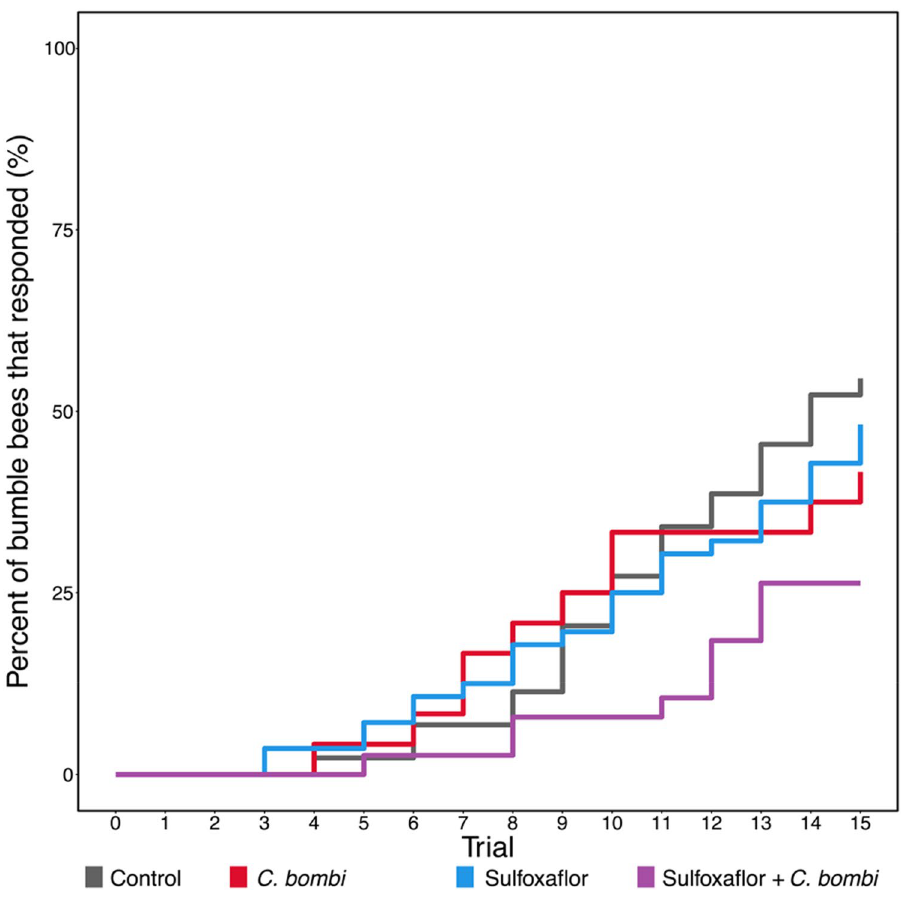
Figure 3. Learning Speed. Cumulative representation of the trials at which responsive workers showed their first conditioned response (control n = 44; sulfoxaflor n = 56; C. bombi n = 24; sulfoxaflor + C. bombi n =